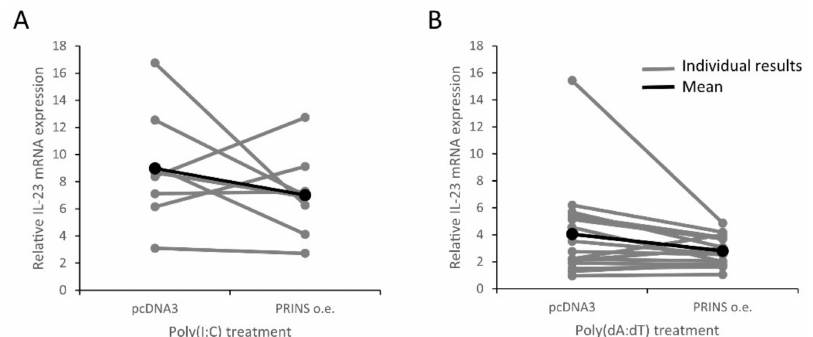
Figure 8. The effect of PRINS overexpression on poly(I:C)- ( A ) and poly(dA:dT)- ( B ) induced IL-23 mRNA expression in NHEKs isolated from the epidermis of 8 ( A ) and 15 ( B ) healthy volunteers. PRINS overexpressing cells were transfected with 0.666 µ g/mL poly(I:C) ( A ), n = 8, or with 1 µ g/mL poly(dA:dT) ( B ), n = 15. Relative IL-23 mRNA expression was determined by the ∆∆ Ct method, normalized to GAPDH mRNA expression and compared to mock-transfected samples. Expression values of individual samples are shown in gray, the mean values of the individual results is shown in